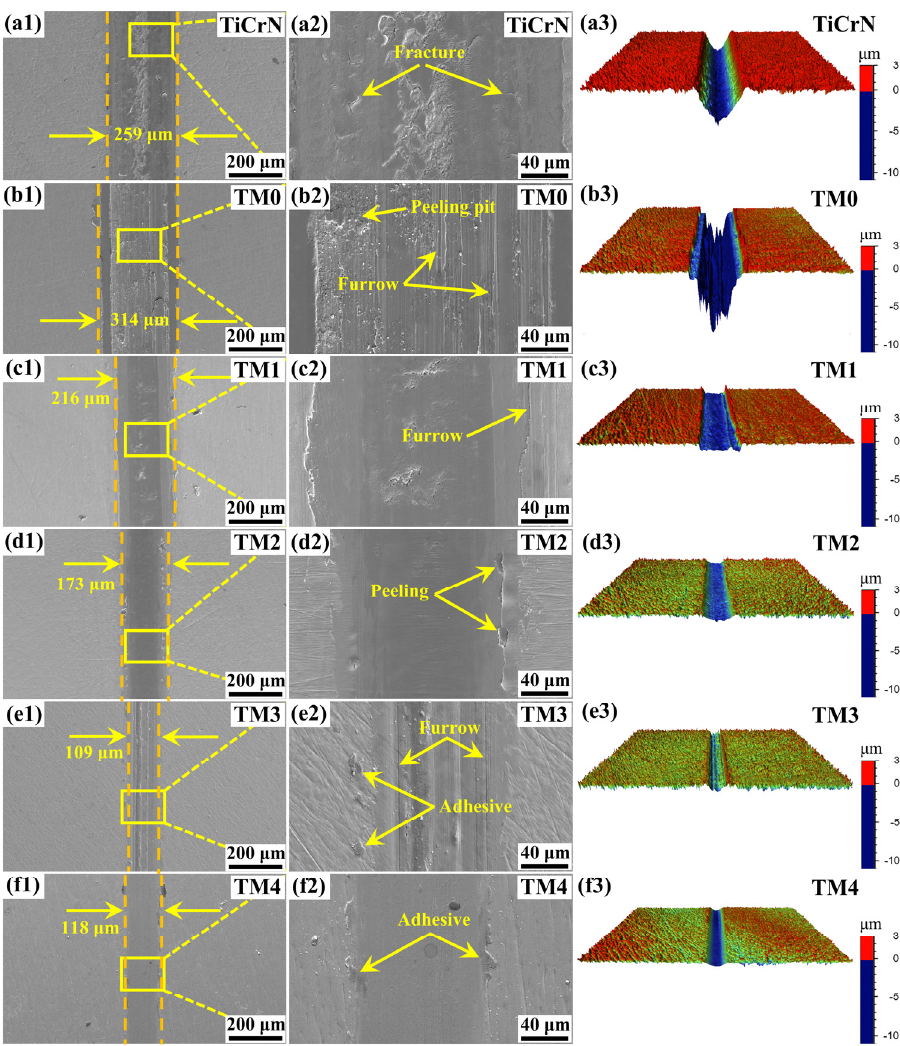
Figure 12. SEM images ( a1 – f1 ), SEM magnified images ( a2 – f2 ), and 3D topographies ( a3 – f3 ) of the wear scar.